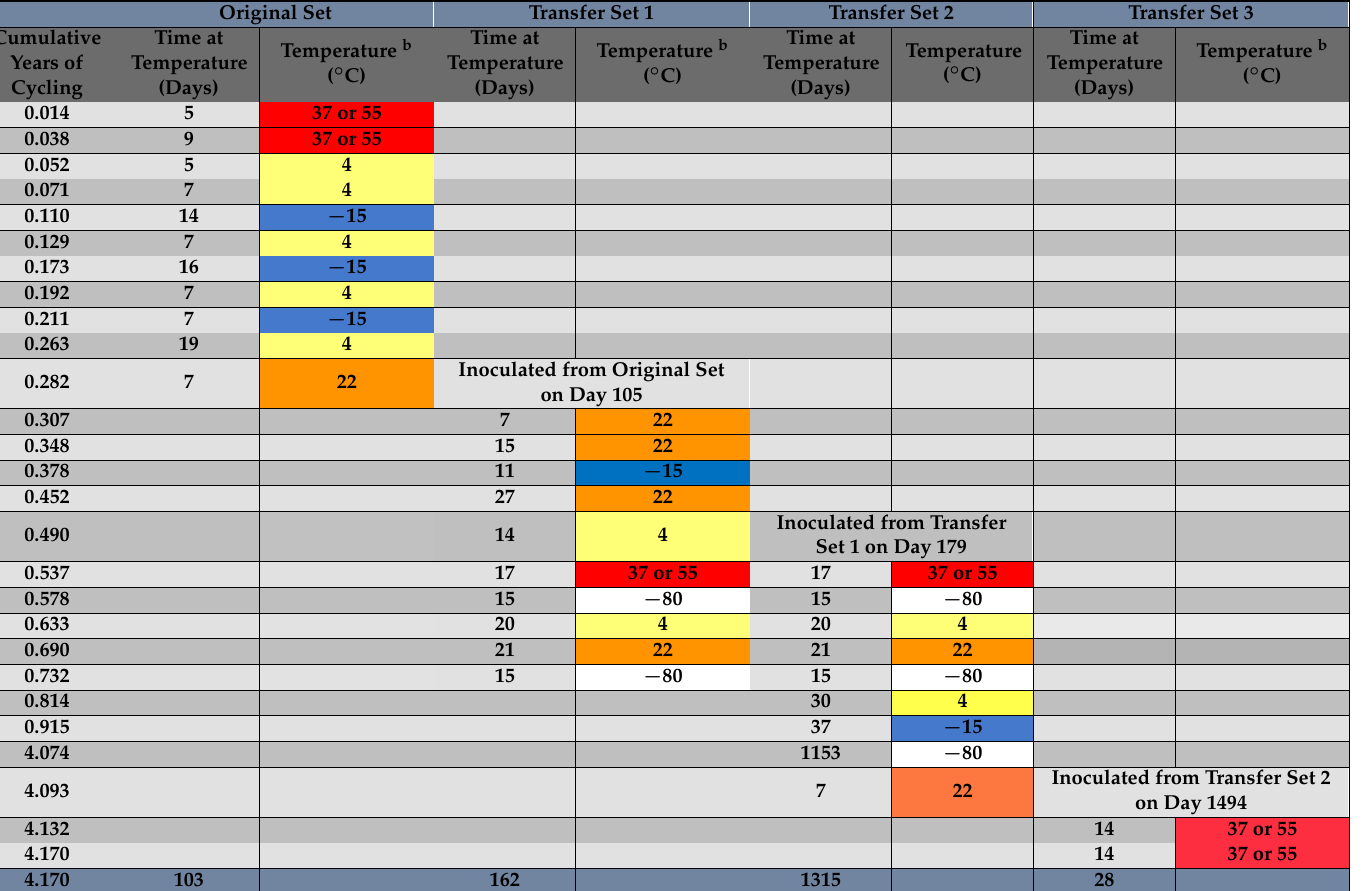
Table 2. Time intervals and temperatures for freeze/thaw cycling for Experiment